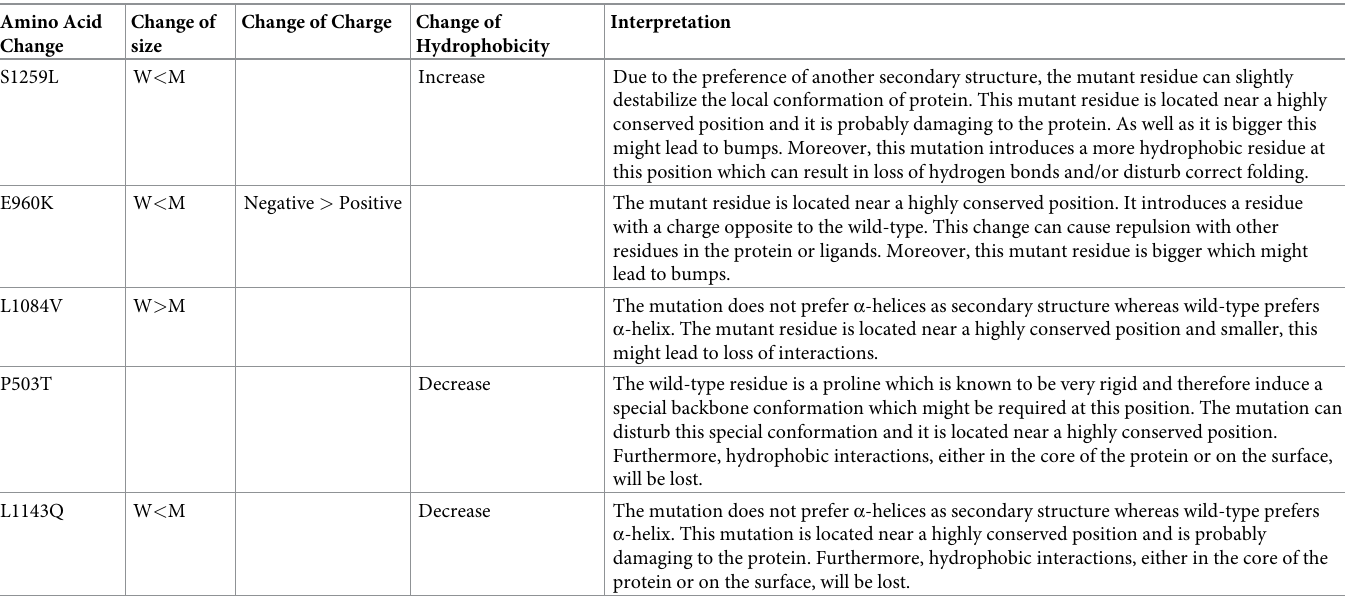
Table 4. Interpretation of the impact of amino acid change on MTUS1 protein structure and stability by